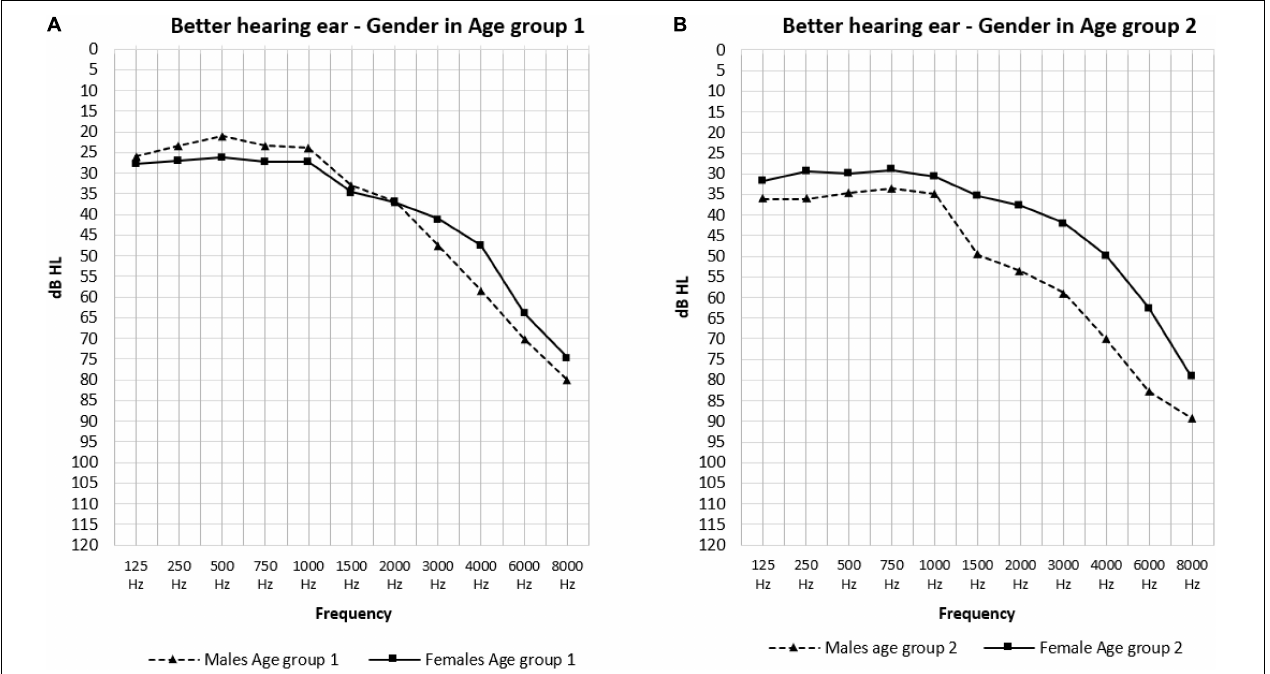
FIGURE 3 | The mean air-conduction thresholds (dB HL) in the better hearing ear according to gender for Age group 1 (A) and 2 (B) separately.